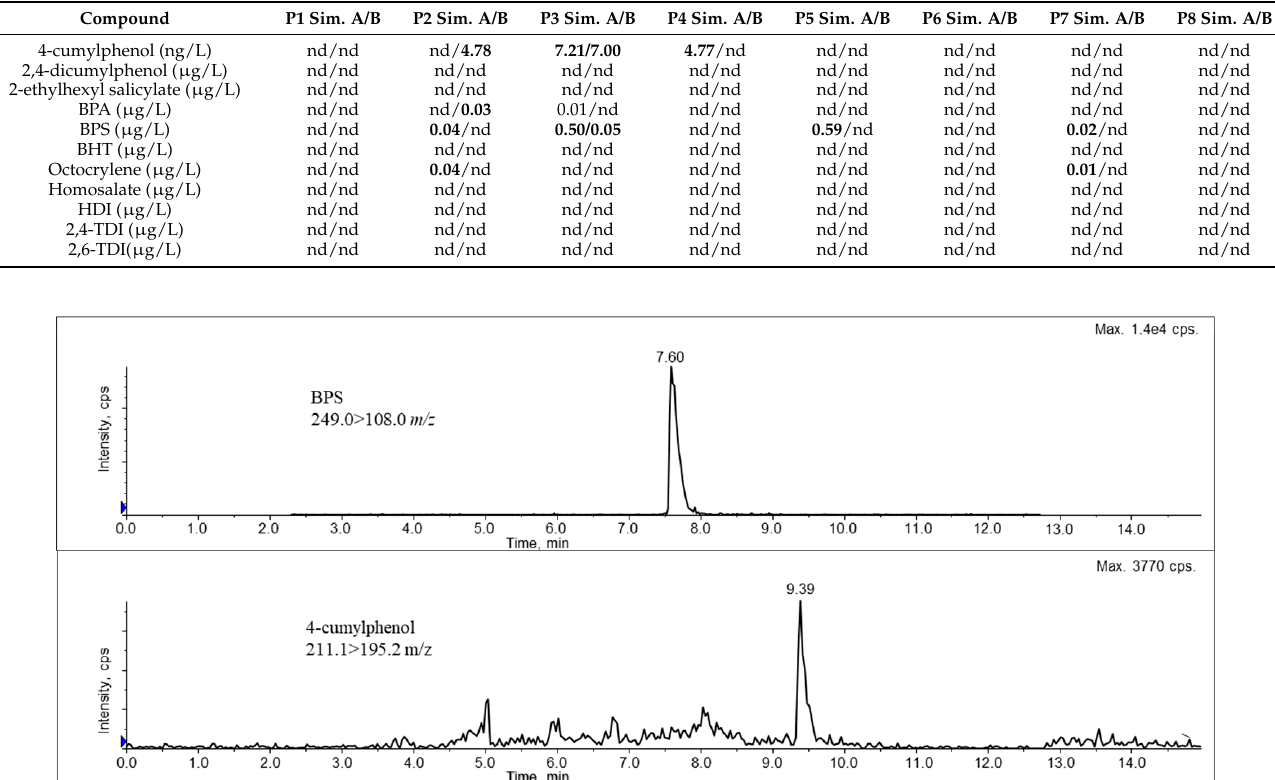
Table 6. Quantitation of analytes in PET bottles samples after specific migration test (concentrations units are specified for each analyte). Sim, simulants; nd, not detectable.